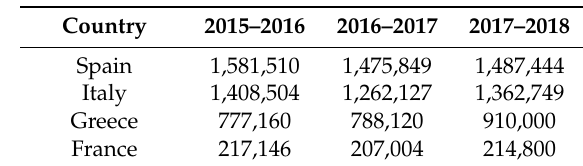
Table 1. Production and estimation of peaches and nectarines (in tons) in the EU-28 main producing countries in different campaigns.